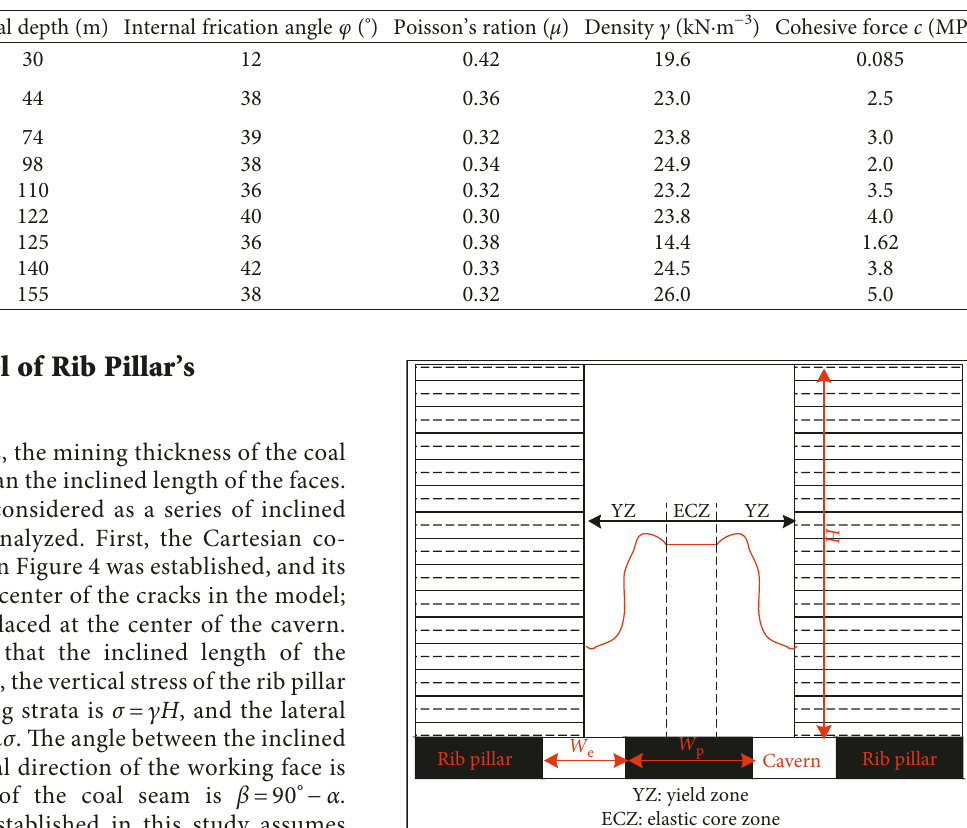
Figure 2: Borehole camera exploration in the rib pillar. (a) Monitoring design. (b) Test equipment YTJ20-BCED. (c) Photographs obtained from borehole at different depths. Table 1: Physical and mechanical parameters of coal-rock [9].